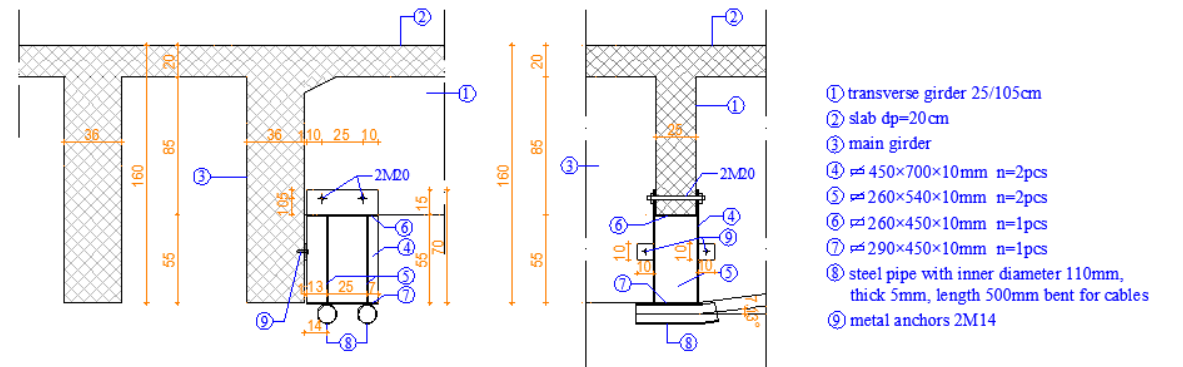
Figure 11. Deviator in the span between columns S2-S3 and S3-S02.